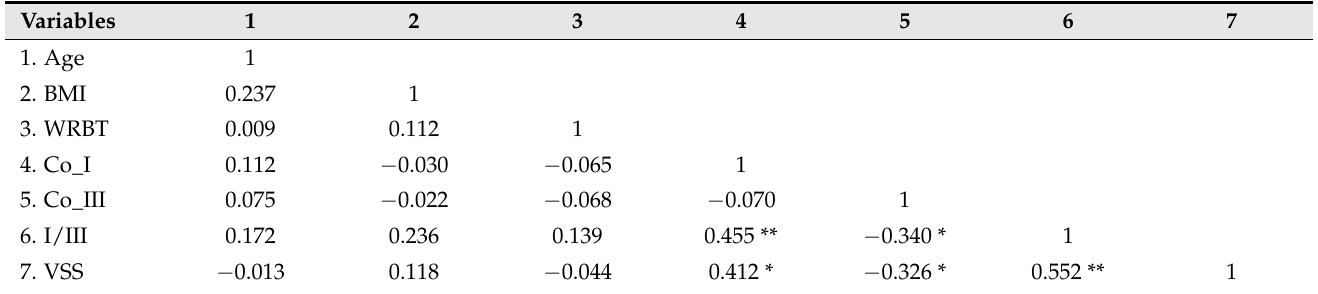
Table 4. Analysis of the correlation between the main variables.